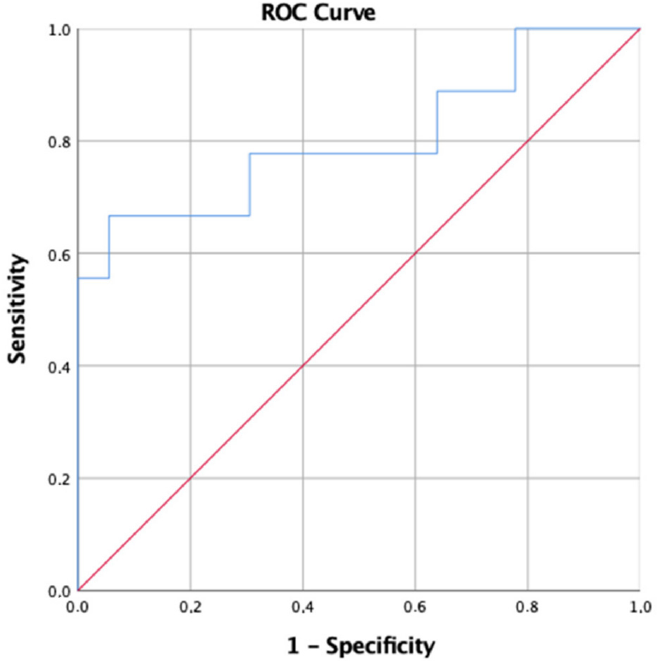
Figure 1. Receiver operating characteristic (ROC) curve comparing accuracy of PaO 2 /FiO 2 at first BGA in relation to the prediction of severe pneumonia. Area under the curve (AUC): 0.802 (95% CI: 0.544–1).